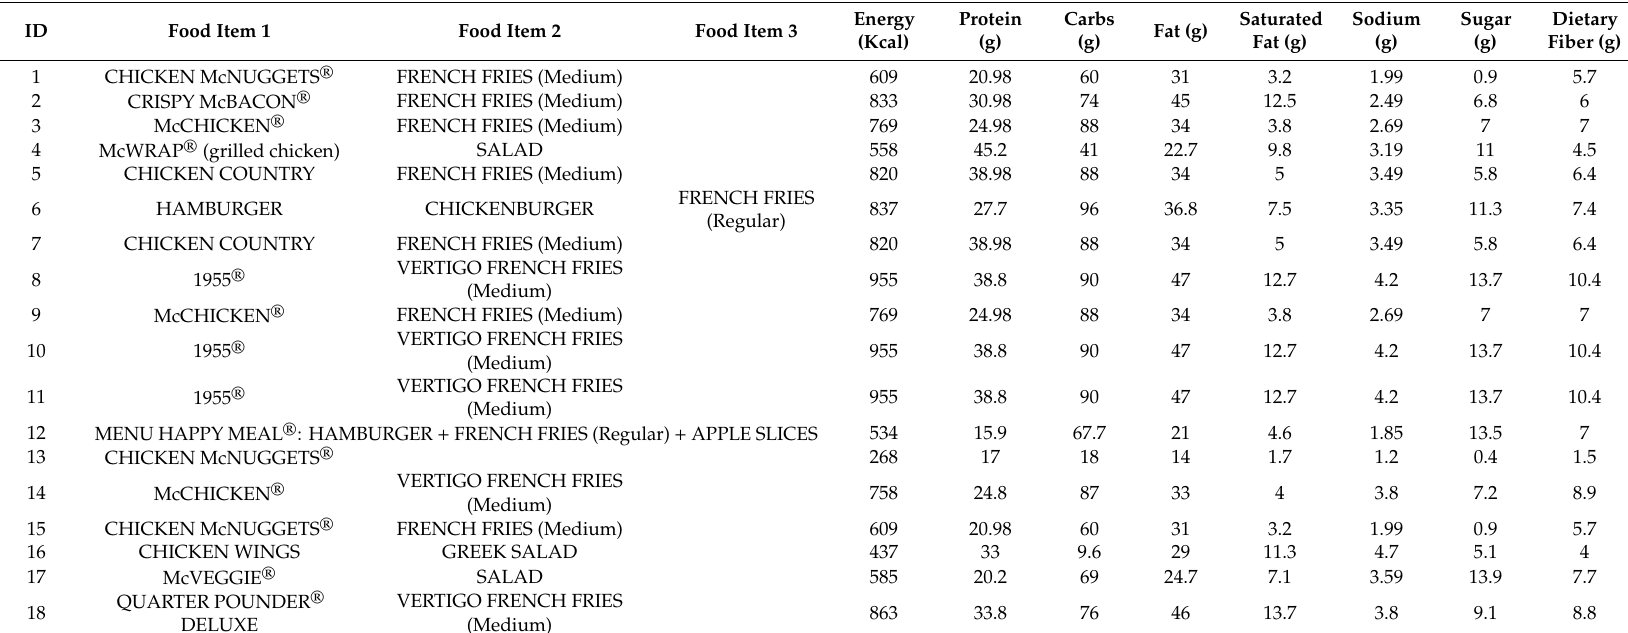
Table 2. Nutritional information for food items included in the